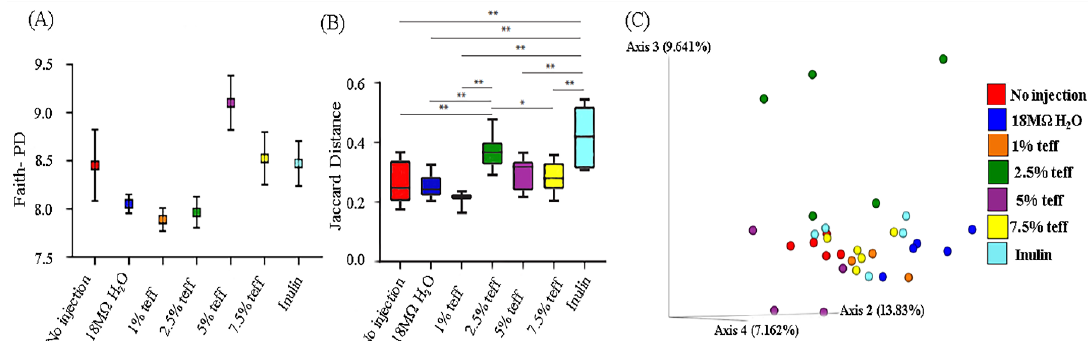
Figure 4. Microbial diversity of the cecal microbiome. ( A ) Measure of α - diversity using Faith’s Phylogenetic Diversity; ( B ) Box-plots of Jaccard distances within the different groups; ( C ) Principal Coordinates Analysis (PCoA) based on Jaccard distances. Each dot represents one animal, and the colors represent the different treatment groups. n =5, * = p < 0.05, ** = p < 0.01.